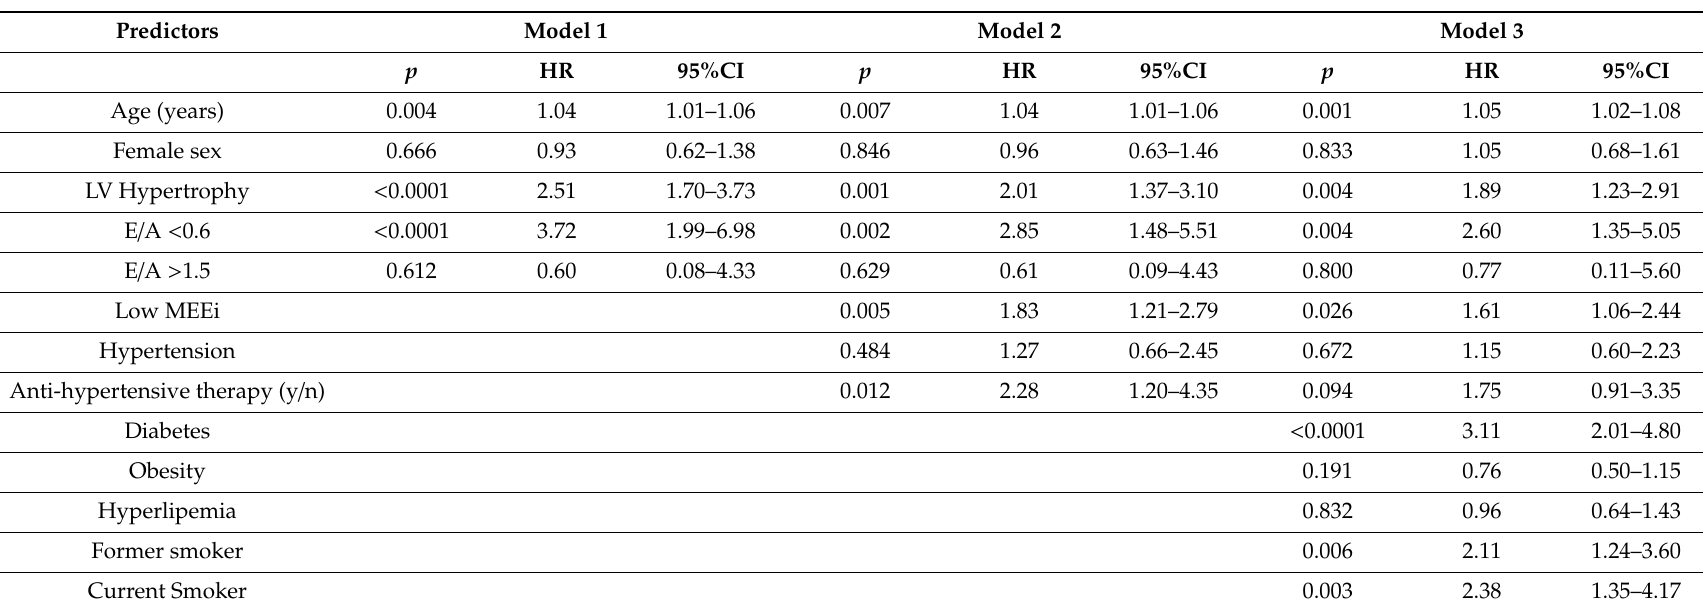
Table 2. Sequential models of proportional hazard analysis of incident heart failure (HF) in relation to low